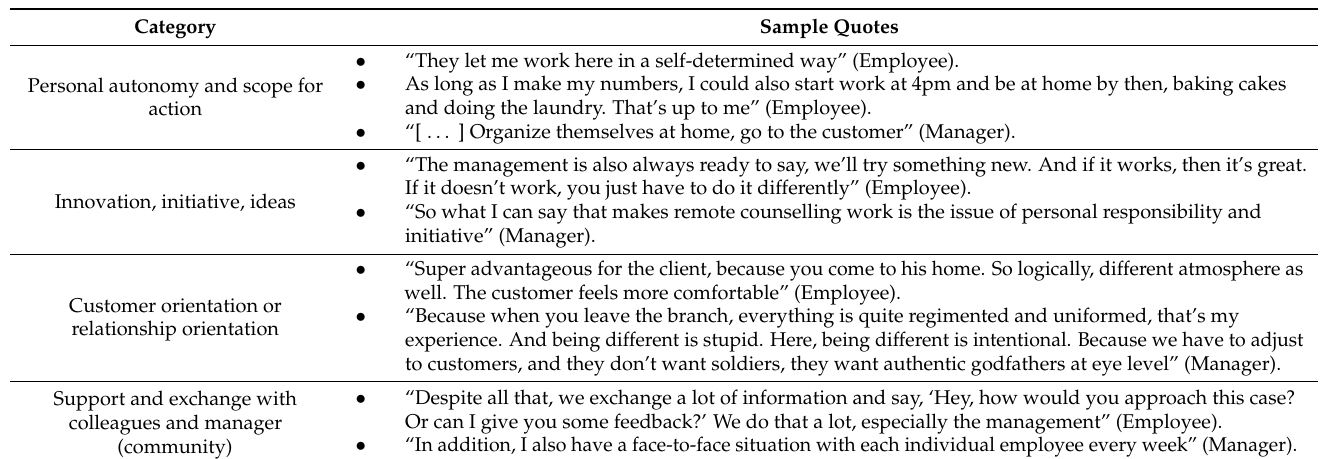
Table 1. Remote group (shortened version).